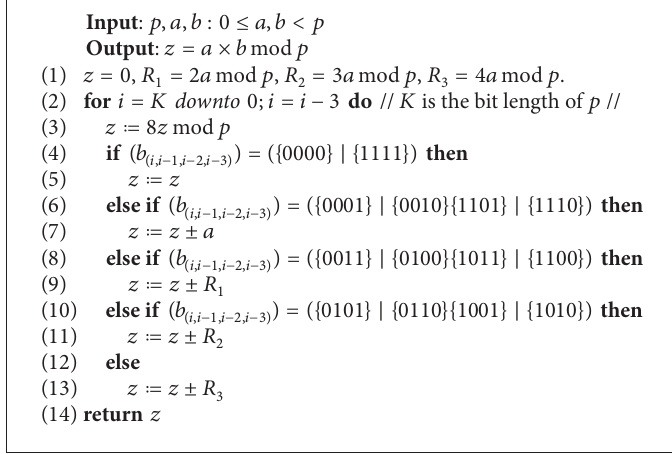
Algorithm 2: Radix-8 BE IM algorithm [30].